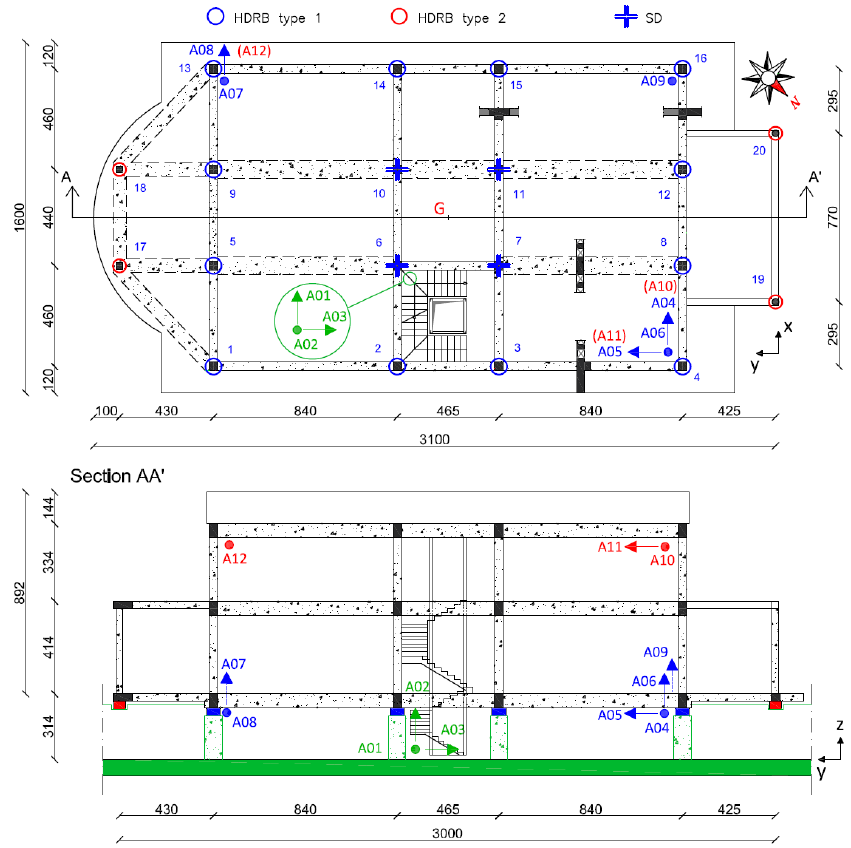
Figure 2. First floor with isolation system and vertical section, with the accelerometers deployment.